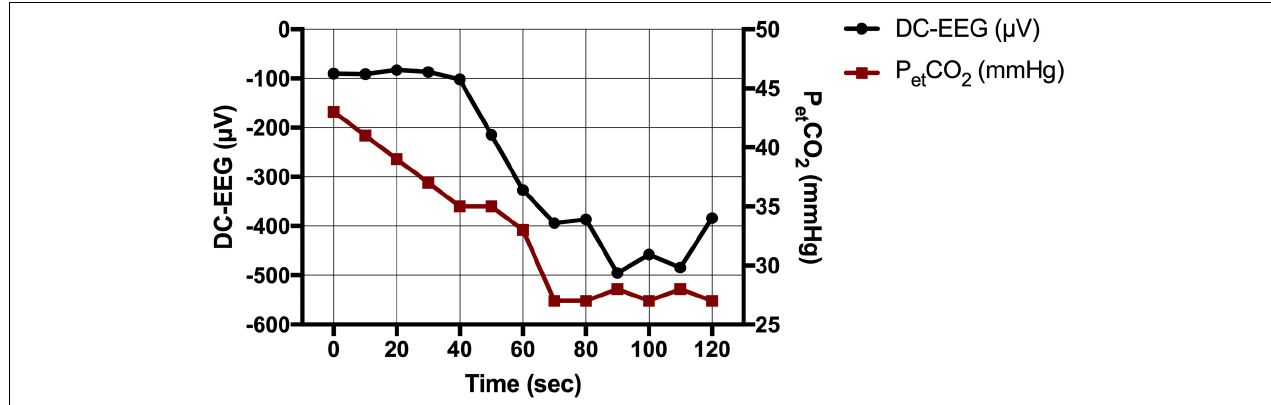
FIGURE 3 | Direct current-electroencephalography and end-tidal CO 2 during hyperventilation (HV). CO 2 drop as measured via the end-tidal CO 2 (p et CO 2 in mmHg) and simultaneous DC shift (in µ V) during HV in an exemplary patient.